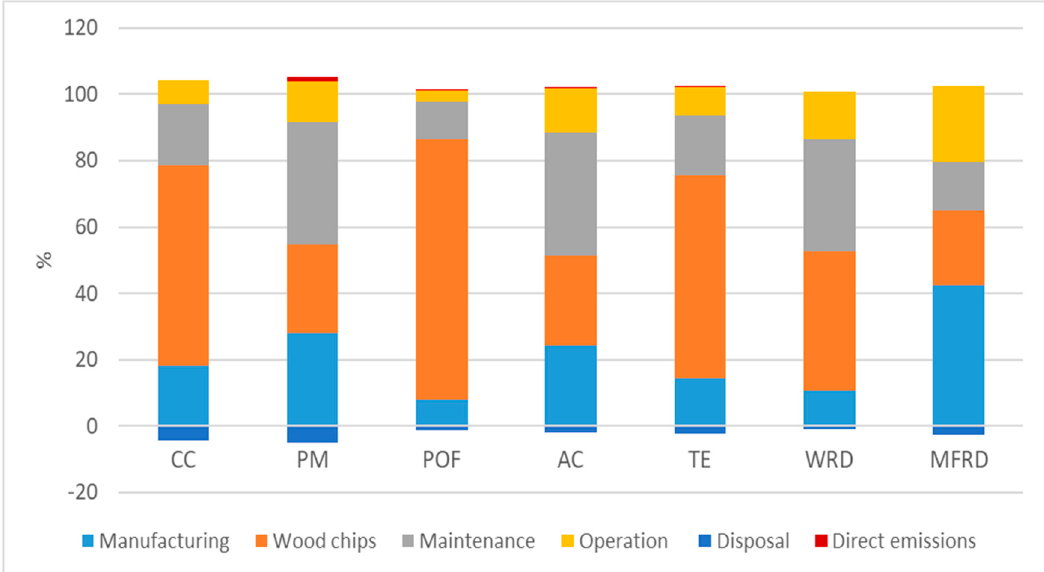
Figure 3. Main contributions to the cradle-to-grave environmental impact of producing heat and electricity with the HBP technology using wood chips as biomass fuel. The presented breakdown is valid for both functional units. CC = Climate change, PM = Particulate matter, POF = Photochemical ozone formation, AC = Acidification, TE = Terrestrial eutrophication, WRD = Water resource depletion, MFRD = Mineral, fossil, and renewable resource depletion.